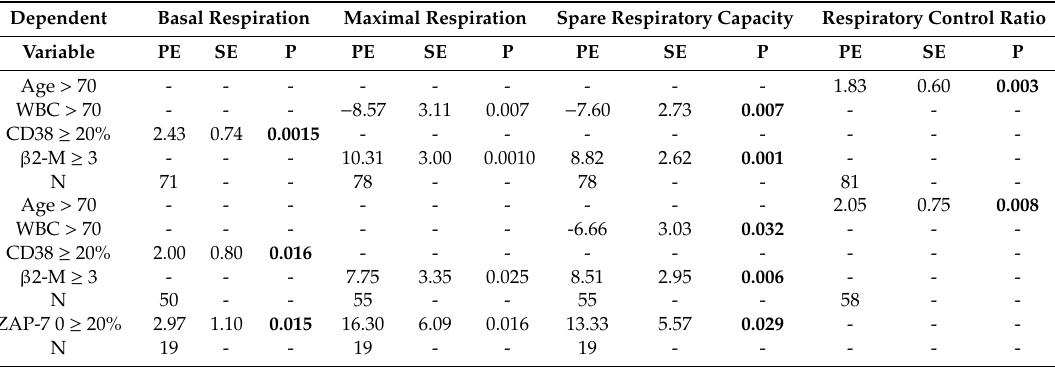
Table 2. Multivariable regression analysis of bioenergetics profiles using the dichotomous parameters. Regression analysis of significant parameters identified when evaluating prognostic markers and bioenergetic parameters in the entire cohort or cohort by sex. ZAP-70, zeta-chain-associated protein of 70 kD; CD38, cluster of di ff erentiation 38; WBC, white blood cell count; β 2-M, β 2-microglobulin; PE, parameter estimate; SE, standard error. Bolded values are